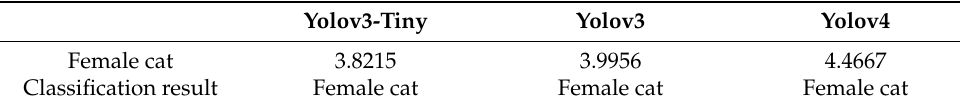
Table 9. Classification results of female cat images by majority voting algorithm.